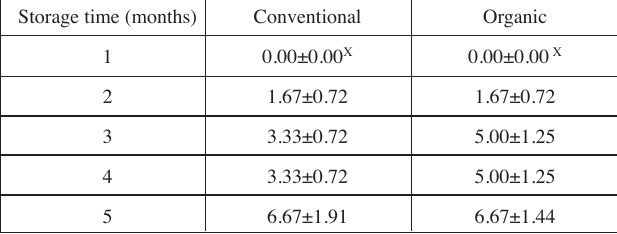
Tab. 2: Incidence of fungal decay in conventionally and organically grown ‘Washington Navel’ oranges during storage at 4°C. Storage time